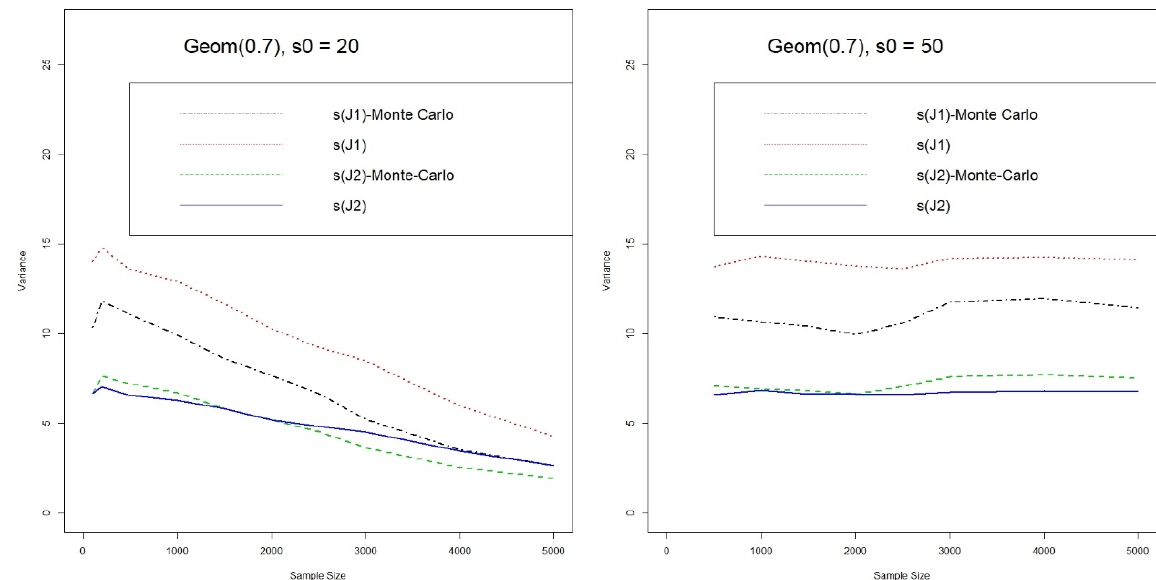
Figure 4. Variance Comparison (Sample vs. Monte Carlo) of Jackknife-type Estimates for the Number of Shared Species (J1 & J2: 1st & 2nd Jackknife estimates).